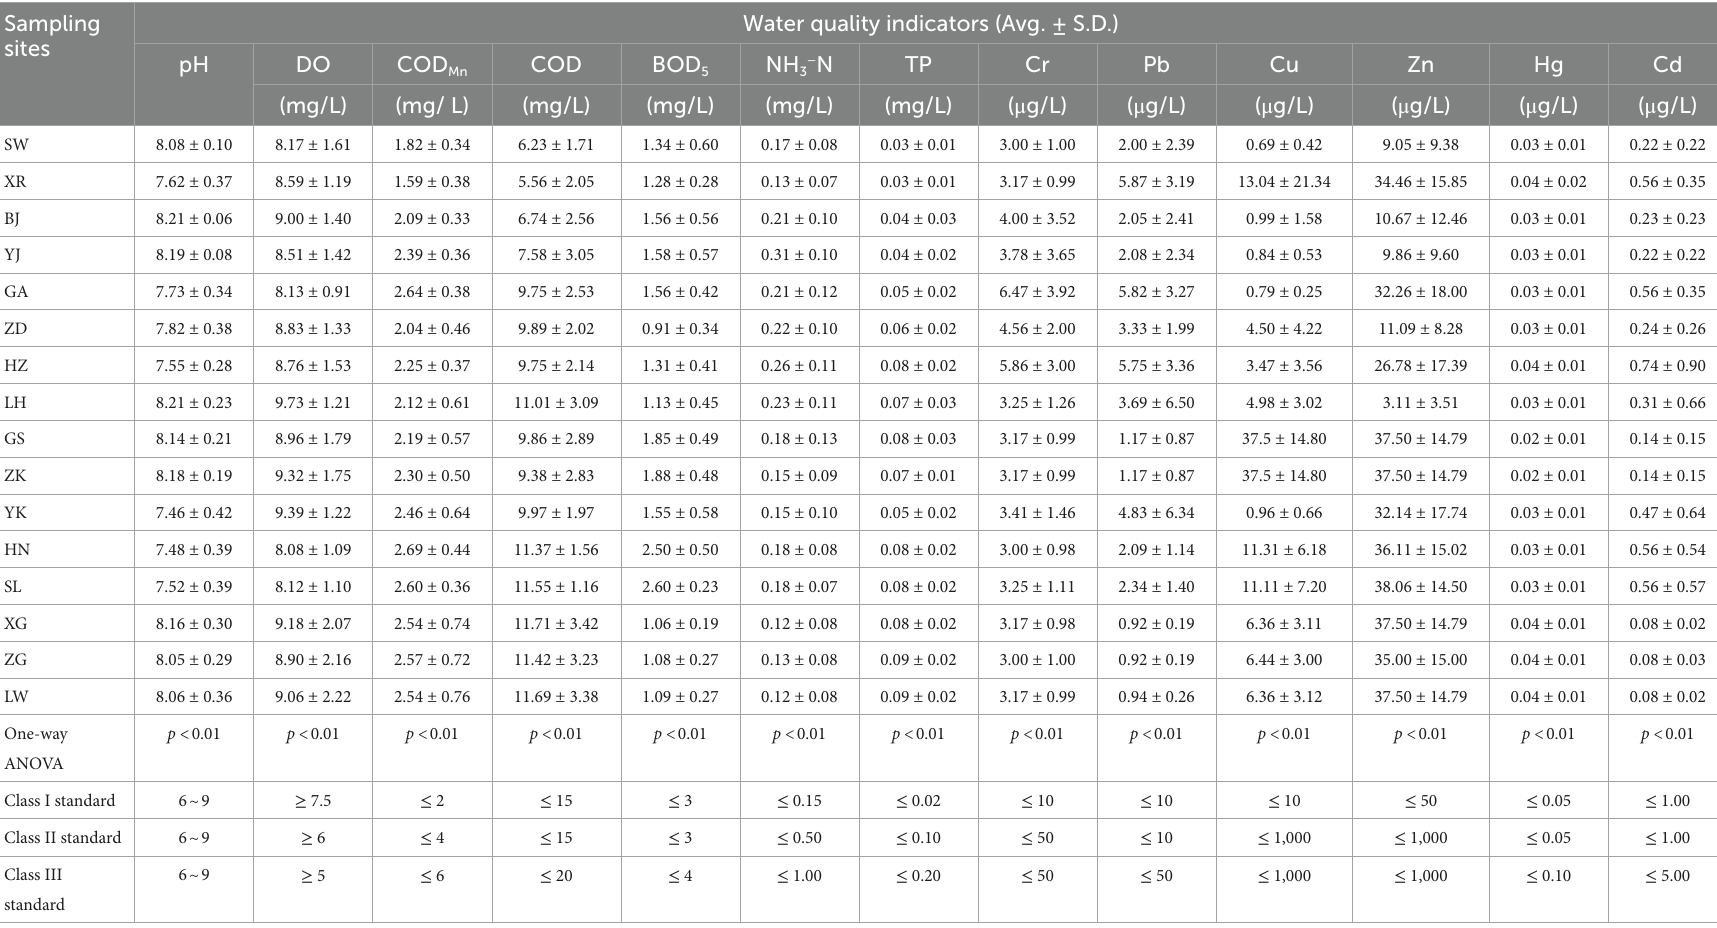
TABLE 3 Water quality summarized as the average and standard deviation for the 16 sampling sites in the middle and downstream of the Hanjiang River (Avg.: Average; S.D.: standard deviation). Sampling